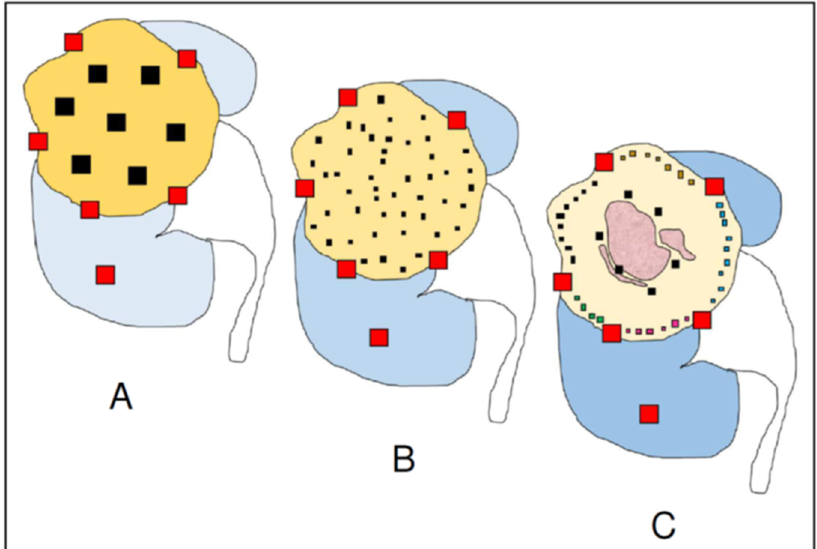
Figure 1. Schematic of tumor sampling evolution in clear cell renal cell carcinoma. The classical sampling protocol ( A ) calls for one block per centimeter of tumor diameter. Multisite tumor sampling ( B ) randomly selects a large number of small tumor samples across the tumor using the same number of blocks as the classic protocol. Advanced multisite tumor sampling ( C ) takes a few samples at the tumor center, where intratumor heterogeneity is low but metastatic genotypes and necrosis (pink areas) are common, and many small samples at the periphery, where intratumor heterogeneity and local invasiveness are high. Here, the small fragments selected are grouped in blocks by sectors, thus enabling the precise location of any key change in any sample to be monitored. Note that tumor/non-tumor, tumor/renal sinus, and tumor/perinephric fat interfaces are similar in the three methods (block shown in red).